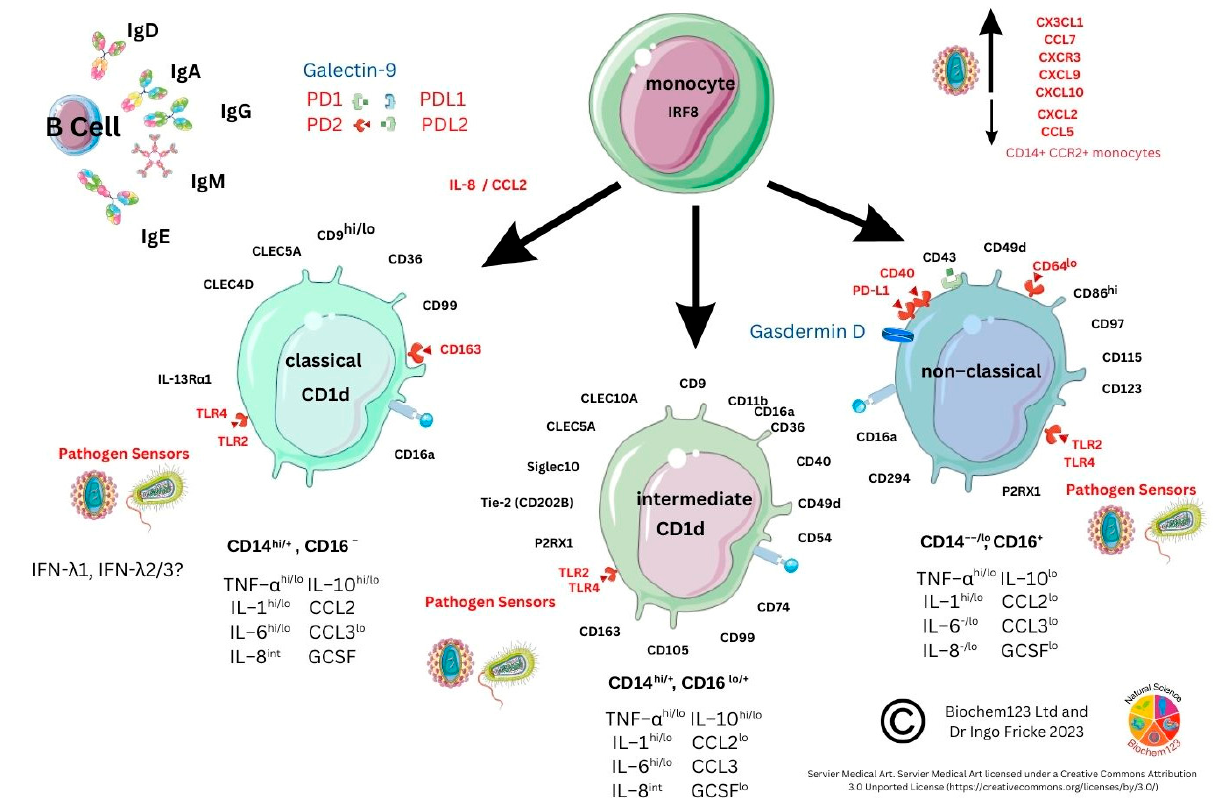
Figure 5. Monocyte cell phenotypes.